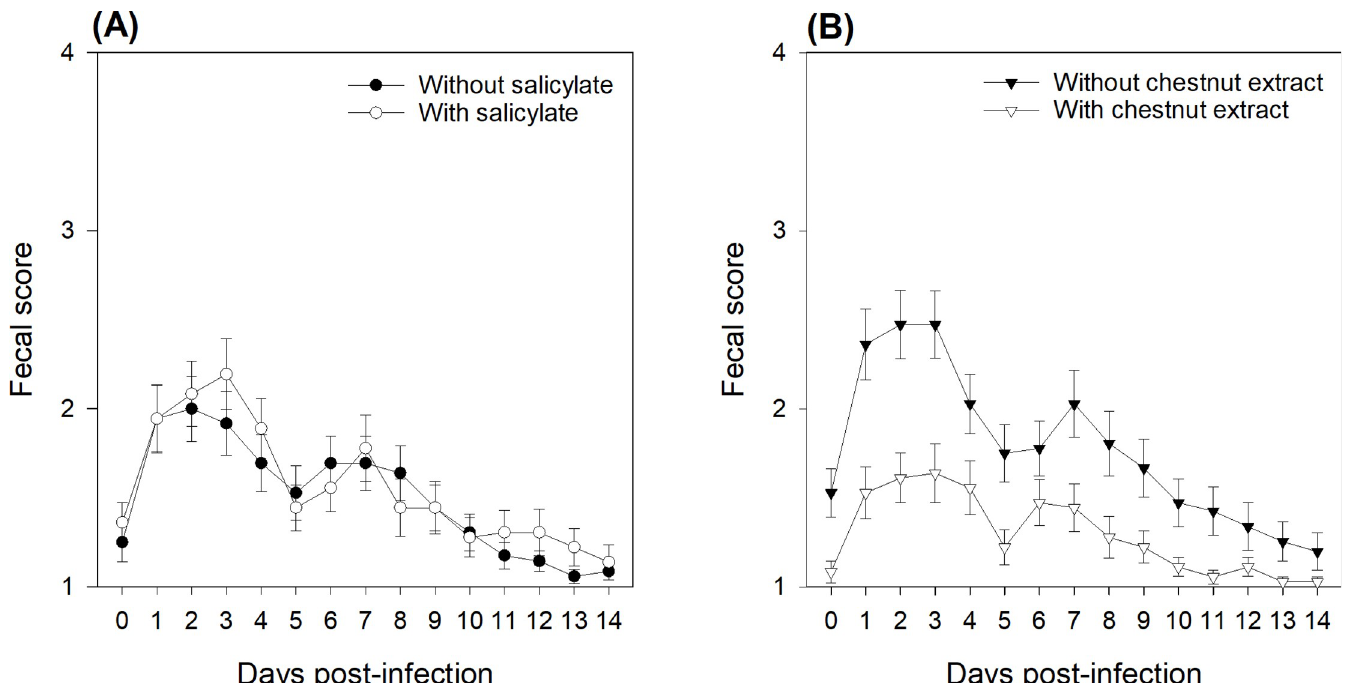
Fig 1. Effects of sodium salicylate supply (A) and chestnut extract supplementation (B) on the fecal scores of piglets assessed from days 0–14 post-infection. During 14 days post-infection, fecal scores were assessed according to the following score scale: 1 = dry pelleted feces, 2 = cow-dung appearance, 3 = liquid diarrhea, and 4 = watery diarrhea. From days 0–4, pigs (N = 36) in the SA+ group were offered a daily dose of sodium salicylate (35 mg/kg BW per day, sodium salicylate, ReagentPlus 1 , S3007, Sigma-Aldrich Chemie GmbH; Buchs, Switzerland). From days 0–4, pigs (N = 36) in the SA- group were offered a daily dose of tap water. Pigs (N = 36) in the CE- group had ad libitum access to a control standard starter diet, which was formulated according to the Swiss feeding recommendations for pigs (Agroscope, 2017). Pigs (N = 36) in the CE+ group had ad libitum access to the chestnut extract-supplemented diet, in which wheat straw in the CE- diet was substituted for with 2% CE (Silvafeed Nutri P/ENC for Swine; Italy). P-values for the main effects: SA supply: P = 0.70; CE supplementation: P < 0.001; Time: P < 0.001; SA × Time: P = 0.01.